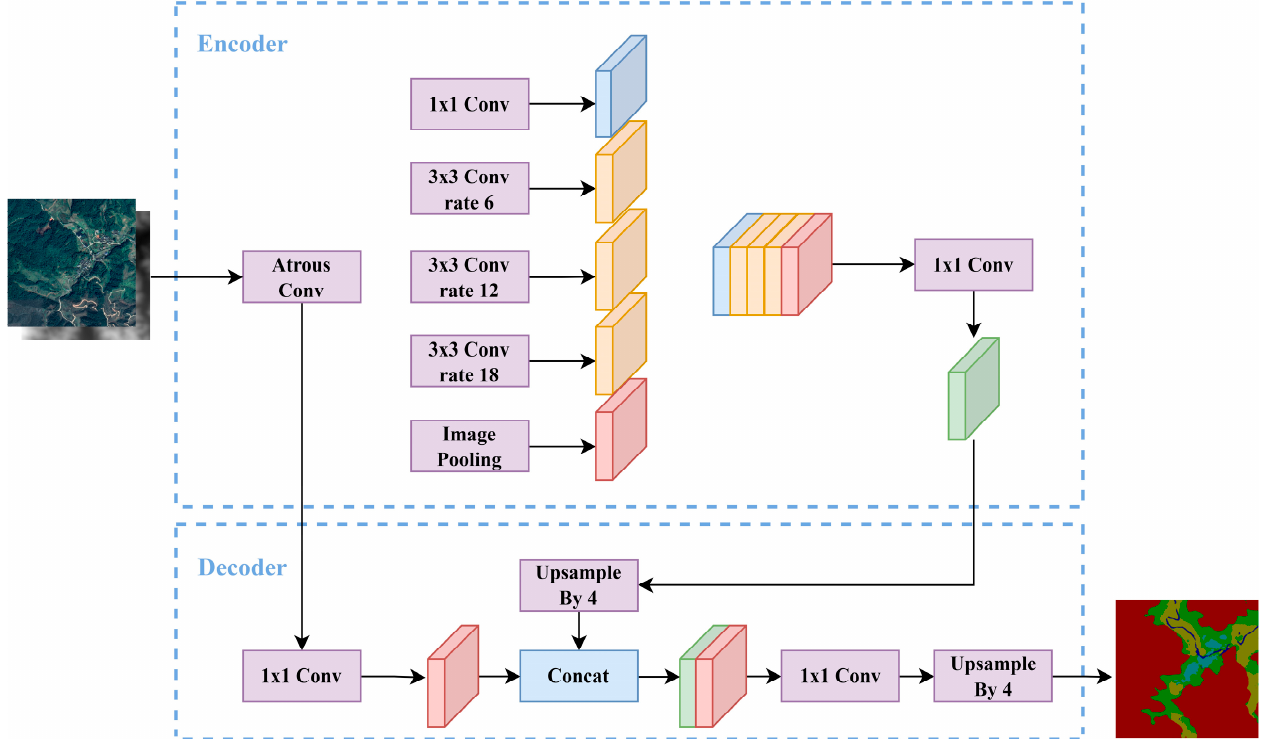
Figure 6. The network structure of the pre-segmentation model in our method. The encoder module encodes multi-scale contextual information, while the decoder module refines the segmentation results along object boundaries.